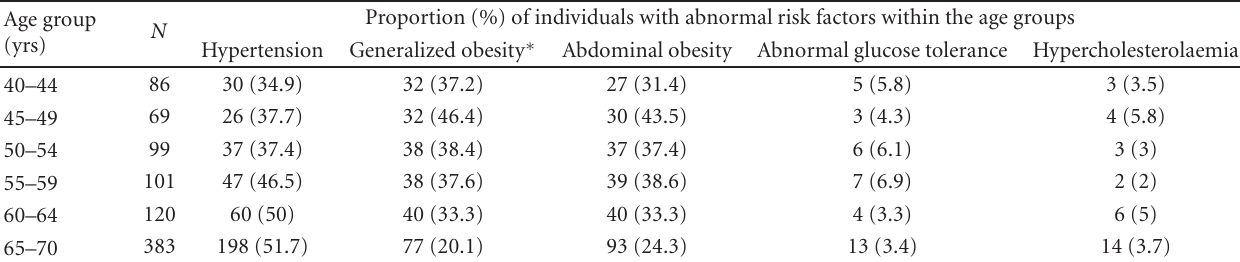
Table 3: Cardiovascular risk factors by age group.